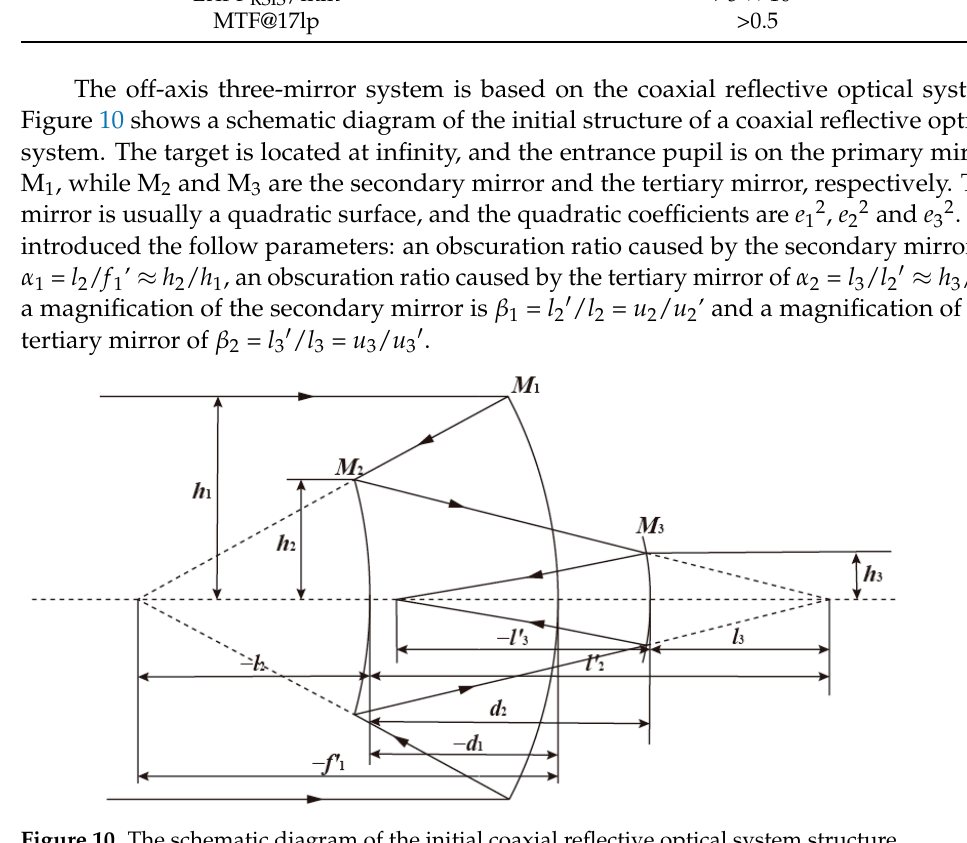
Table 5. RS design index.